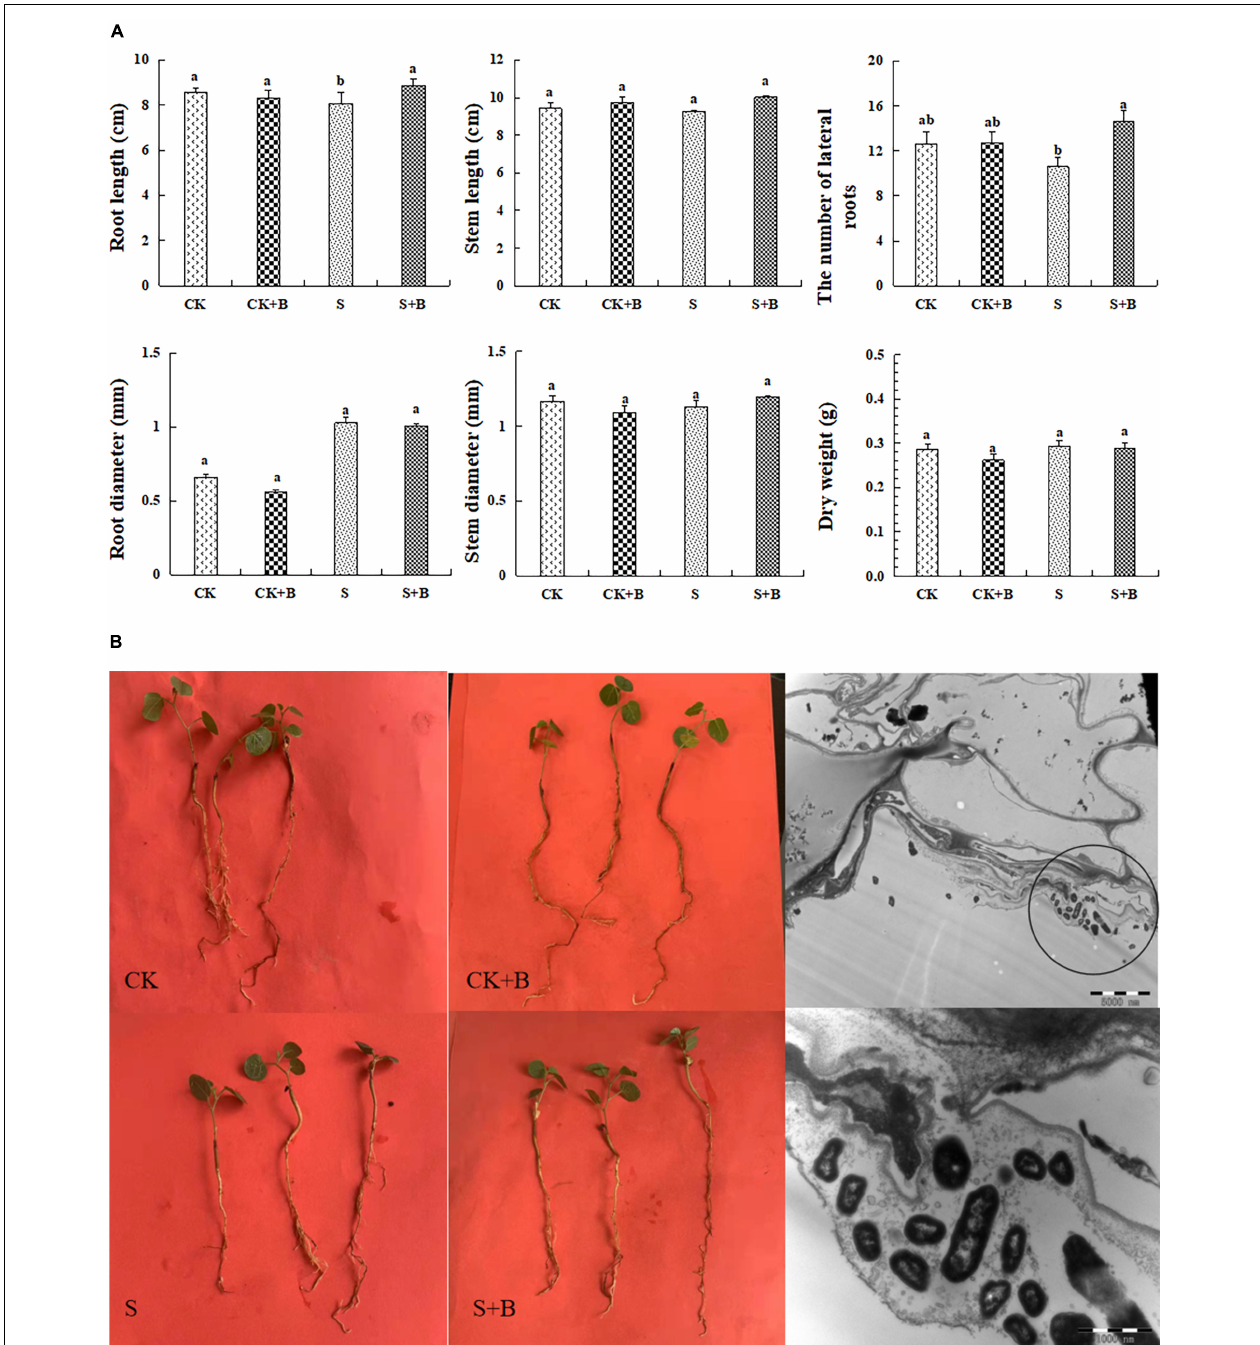
FIGURE 1 | (A) Effect of B. cereus on seedlings growth of G. uralensis under control (CK) and salt stress (S) conditions. Data are expressed as the mean ± SE ( n = 6). The different letters within the different treatments indicate the significant difference at P < 0.05. (B) The growth condition of seedlings under different treatments and colonization of B. cereus in the roots in G.